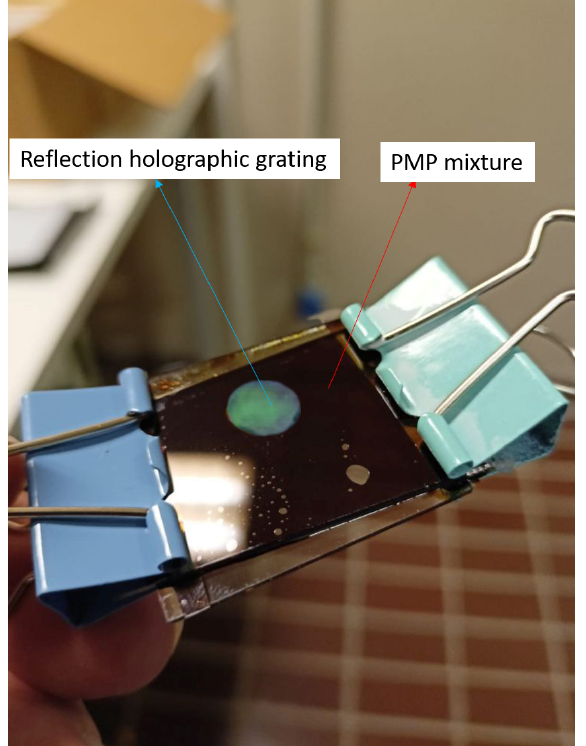
Figure 2. The high resolution reflection grating (the green spot) embedded into the photomobile polymer (brown part).